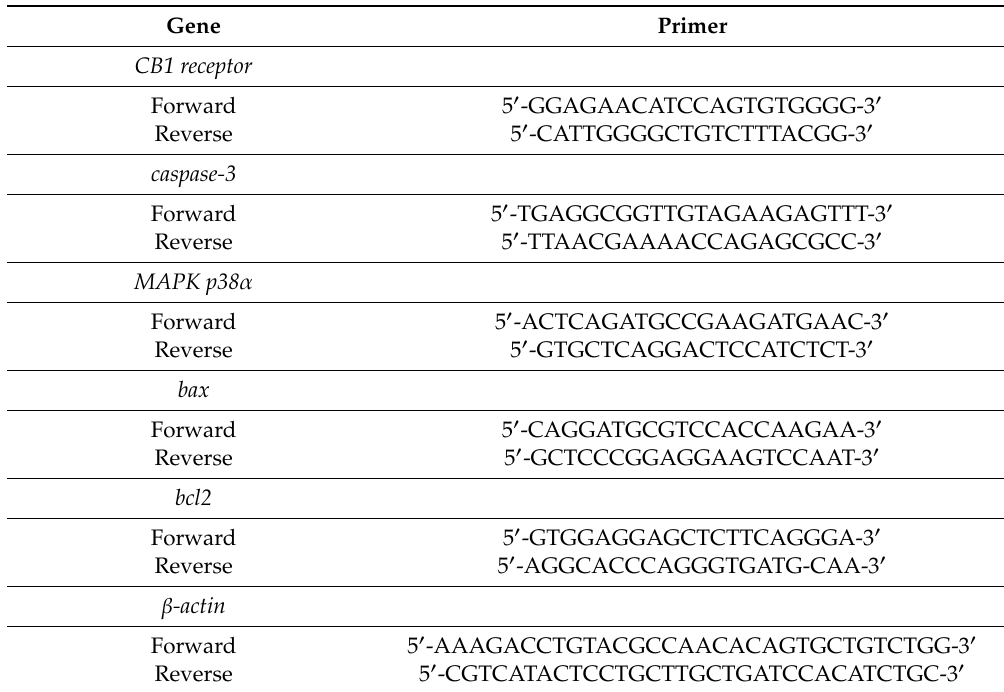
Table 2. Sequences of primers for gene expression